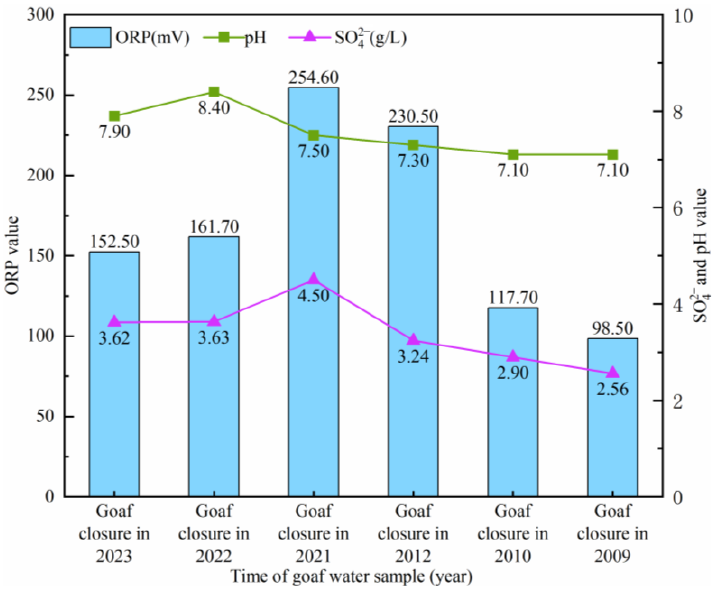
Figure 11. The change characteristics of mine water ions (the red arrows in the graph indicate the trend of ion changes).